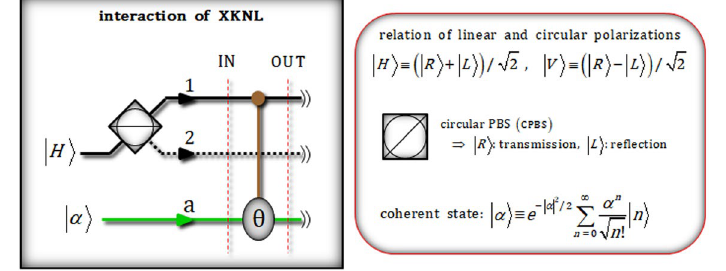
Figure 1. Plot schematically represents the interaction of XKNL between a photon and probe beam (coherent state). After this interaction, the conditional phase shift, θ , in the phase space of coherent state is (or not) induced by Kerr effect due to polarization ( R or L ) of photon. Here, a photon plays the role of control qubit (signal) which can perform conditional phase shift to target system (probe beam: coherent